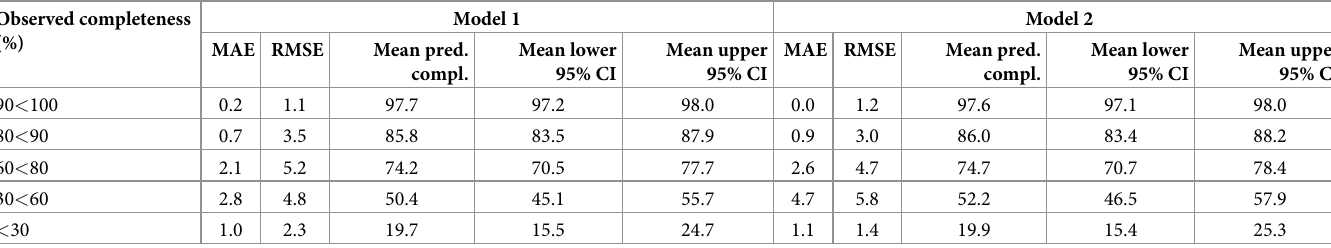
Table 3. Model goodness of fit by level of observed death registration completeness (%), both sexes. Observed completeness (%)